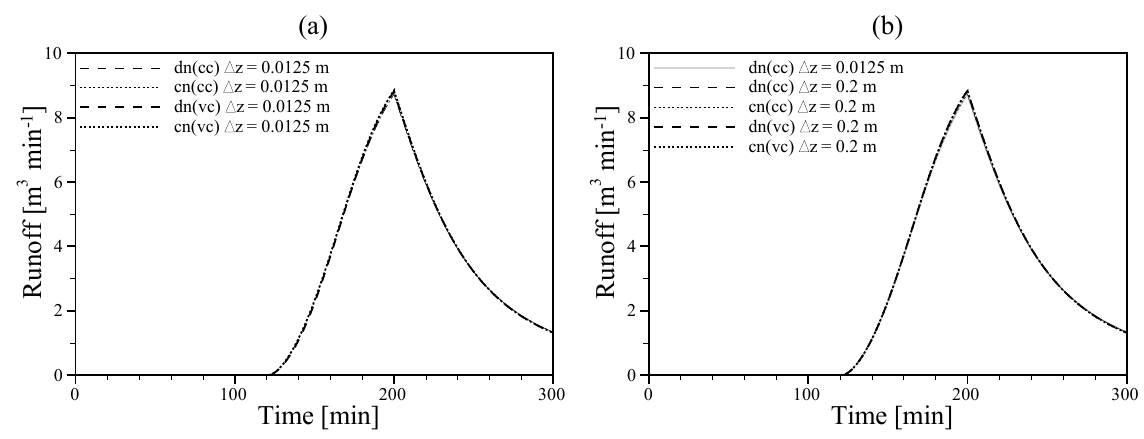
Figure 2. Outflow response for excess saturation on a hillslope (first scenario) using different vertical discretizations.